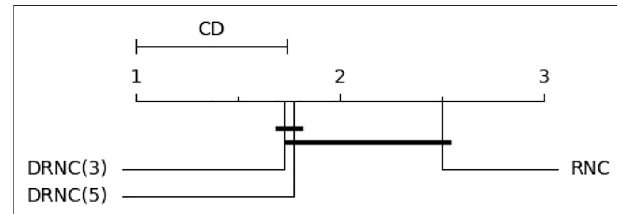
FIGURE7| Criticaldistancediagramfortherulenetworksonthearti fi cial datasets with a signi fi cance level of 95 % . Learners that are not statistically different from one another are connected.